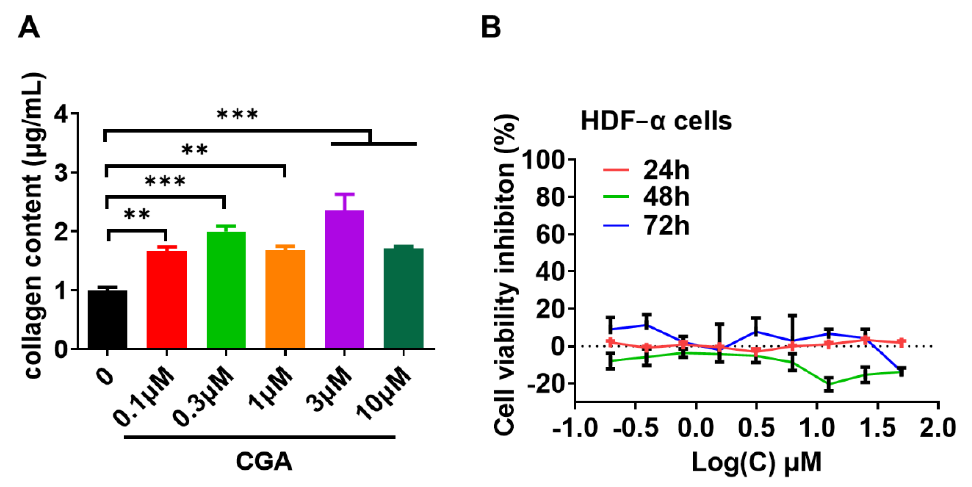
Figure 2. The effect of CGA on collagen secretion in HDF- α cells. ( A ) The soluble total collagen content in the supernatant of HDF- α cells were measured after exposure of CGA for 48 h. ( B ) The cell viability inhibition of HDF- α cells treated with CGA for 24, 48, or 72 h were detected by MTT assay. The values are expressed as the mean ± SD. from three experiments. ** p ≤ 0.01, *** p ≤ 0.001 indicate a significant difference. Table 1. The BioMAP HDF3CGF system utilized in the screening study. The cell types shown cultured and stimulated with the environmental factors in the presence of CGA for 72 h. The biomarker readouts listed were measured.